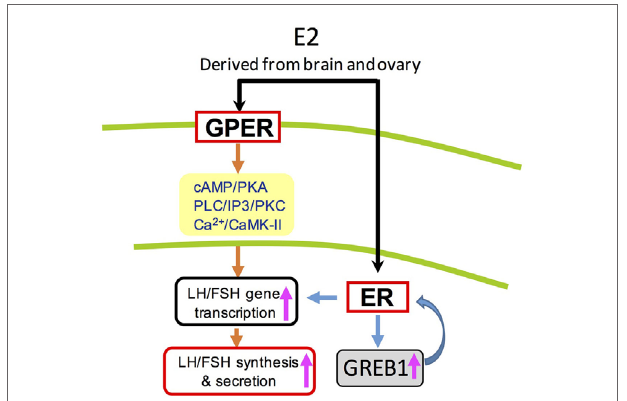
FigUre 8 | Working model of luteinizing hormone (LH) and follicle-stimulating hormone (FSH) regulation by E2 in grass carp pituitary cells. In grass carp pituitary cells, E2 could activate both protein-coupled estrogen receptor (GPER) and ER to induce LH and FSH secretion and synthesis. These effects appear to be mediated through the adenylyl cyclase/cAMP/protein kinase A, phospholipase C (PLC)/inositol 1,4,5-triphosphate/protein kinase C (PKC), and Ca 2 + /calmodulin/CaM-dependent protein kinase II (CaMK-II)